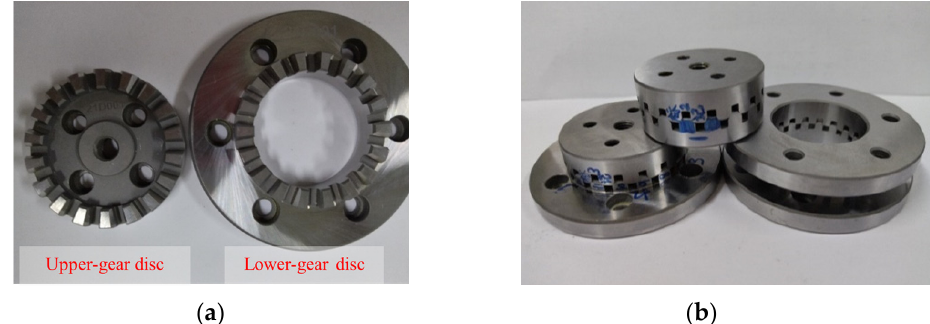
Figure 3. The fabricated end-toothed disc. ( a ) Matched with a pair of upper- and lower-gear discs; ( b ) matched with two upper-gear discs or two lower-gear discs.